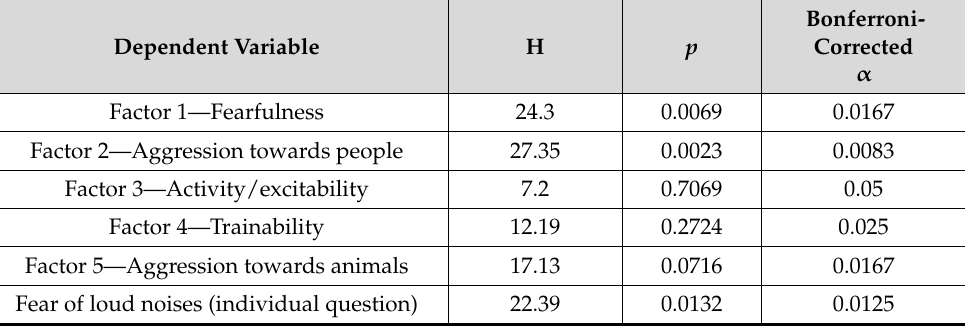
Table 13. Results of Kruskal–Wallis tests assessing the effect of litter on the DPQ personality factors and fear of loud noises, and the corrected alpha level following sequential Bonferroni